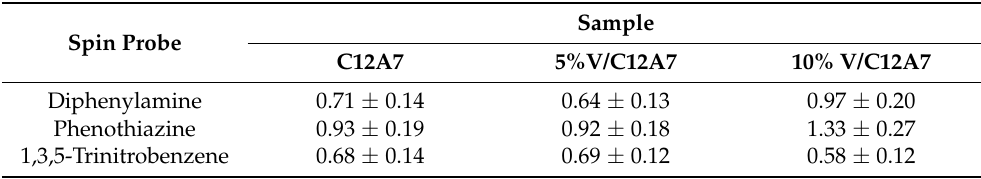
Table 2. Concentration of the active sites (10 18 g − 1 ) over C12A7 and V/C12A7 samples measured by a spin probe EPR